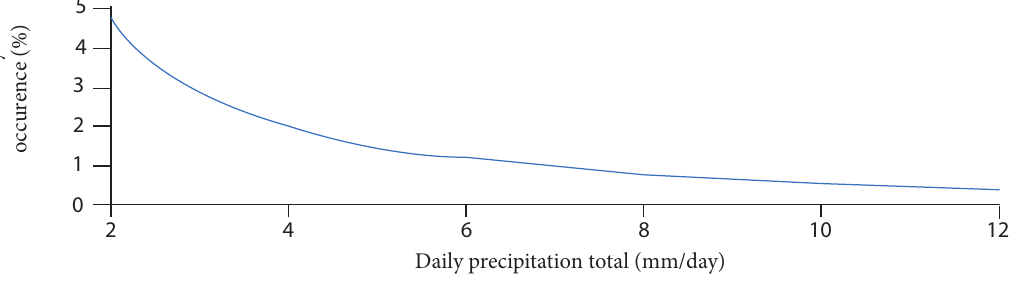
Figure 5. Probability of occurrence (%, y axis) of a daily precipitation total above a given value (mm/day, x axis) based on the log-normal